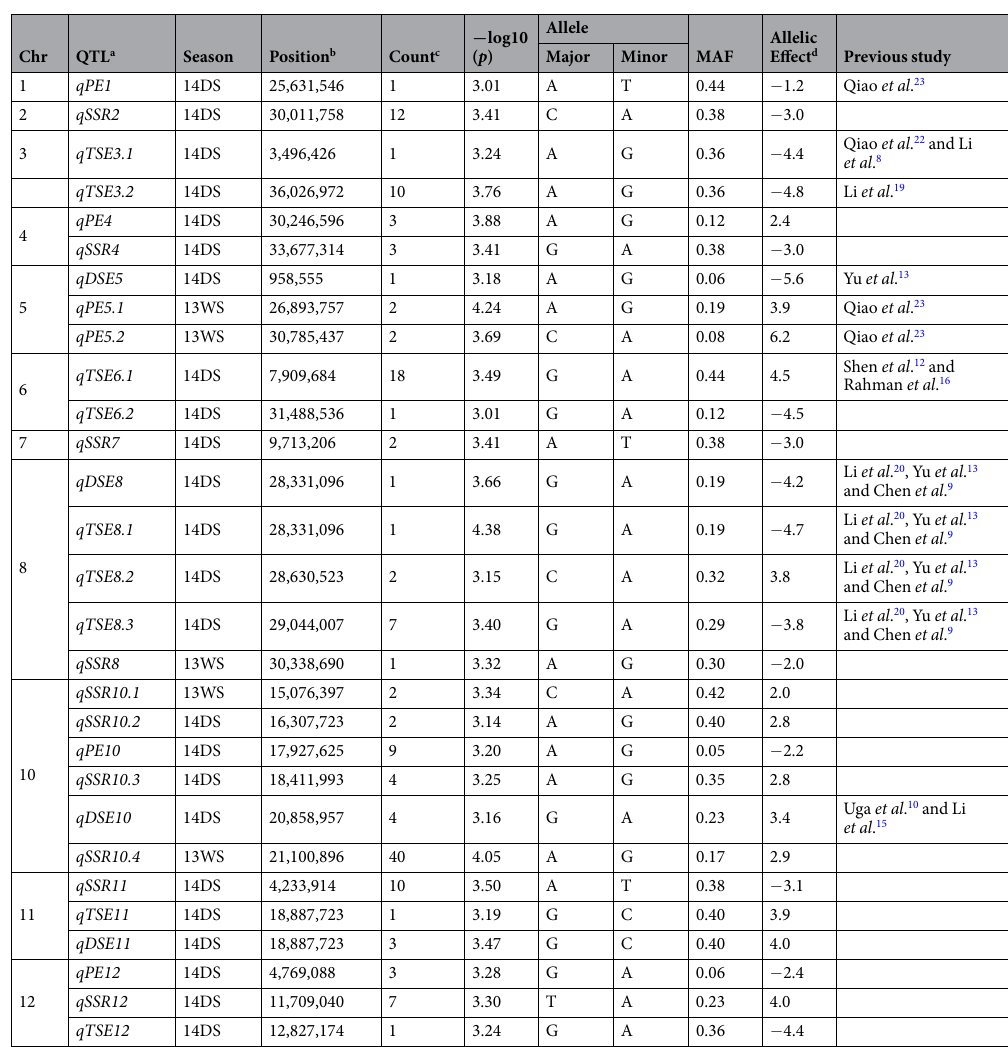
Table 3. Significant association identified by GWAS. Chr = Chromosome number; 13WS = wet season of 2013; 14DS = dry season of 2014; MAF = minor allele frequency. a QTL was designated following the nomenclature proposed by McCouch and CGSNL 51 ; b Position of the SNP showing the most significant association in the QTL region; c Amount of significant trait-SNP association ( P < 0.001) detected in the region; d A positive value of allelic effect means that the minor allele has a higher